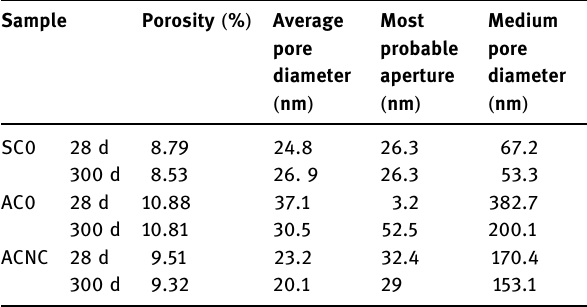
Table 4: MIP results of the concrete